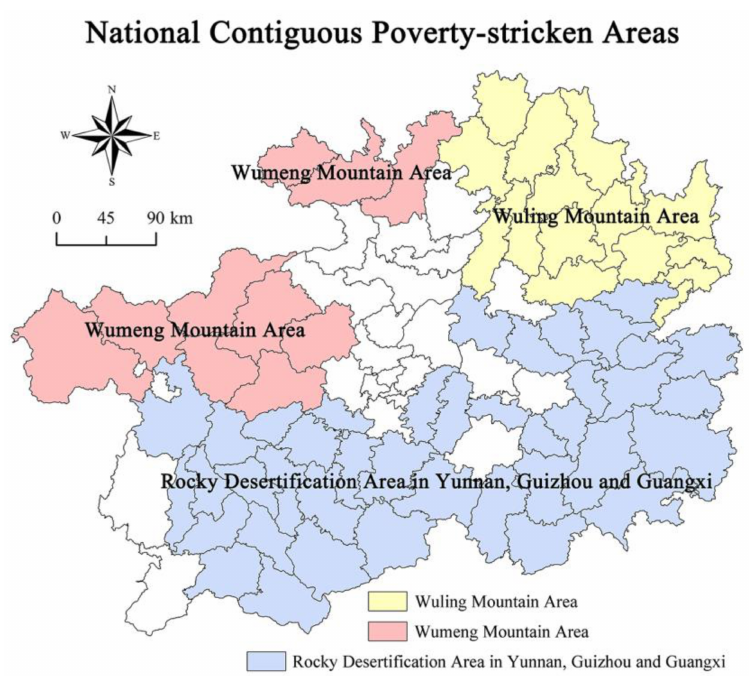
Figure 12. Distribution of national contiguous poverty-stricken areas of Guizhou Province.